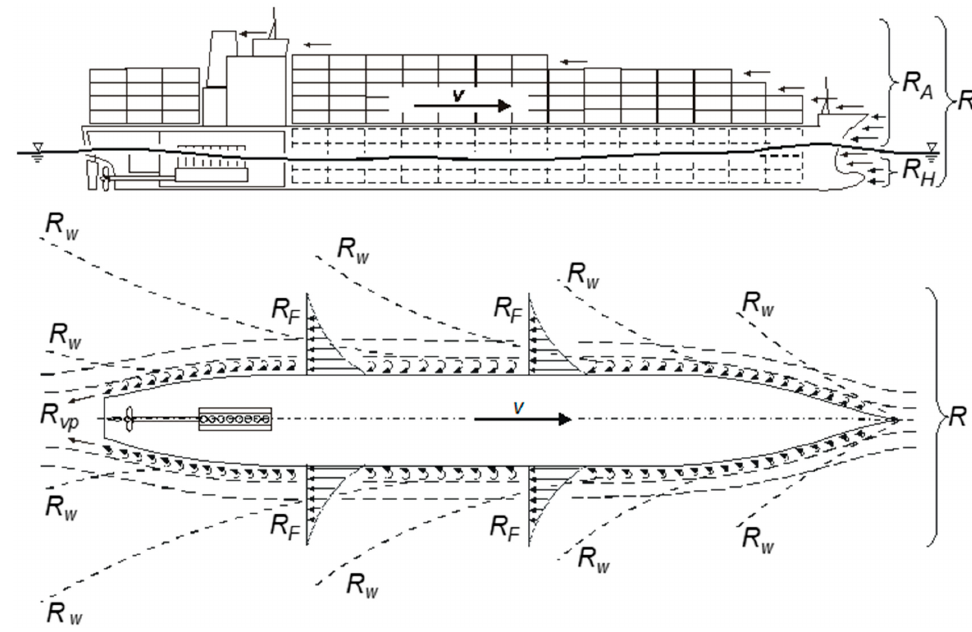
Figure 3. Distribution of the total hull resistance [13].